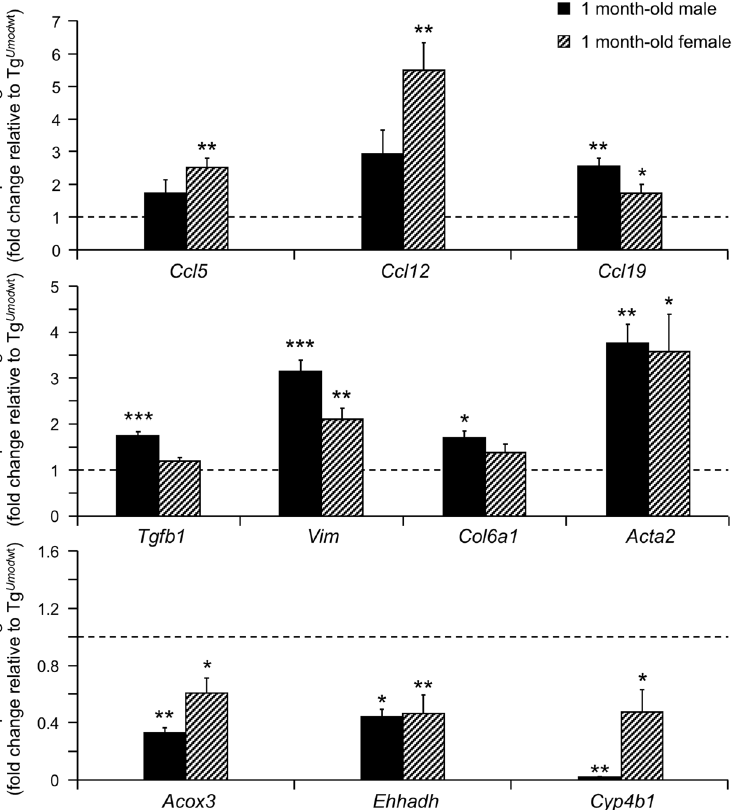
Figure 3. Renal transcript levels of genes belonging to inflammation (upper panel), fibrosis (middle panel) and lipid metabolism (lower panel) pathways, as detected by real-time RT-qPCR in 1 month-old male or female Tg Umod C147W mice. Gene expression is reported as relative to age- and sex-matched Tg Umod wt mice (n = 5/group). Data are expressed as mean ± s.e.m. * P < 0.05; ** P < 0.01; *** P < 0.001 (unpaired t -test).